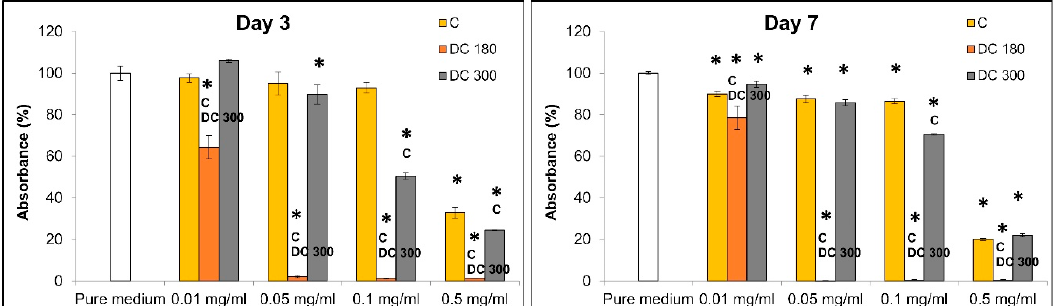
Figure 5. Mitochondrial activity of human dermal fibroblasts grown in a pure cultivation medium and in media with unmodified curcumin (C), or with curcumin degraded at 180 ◦ C (DC 180) or at 300 ◦ C (DC 300) in various concentrations (0.01, 0.05, 0.1, and 0.5 mg / mL) on days 3 and 7 after adding the agent. Arithmetic mean ± SD from 4 measurements, ANOVA, Student–Newman–Keuls method. Statistical significance ( p ≤ 0.05; depicted above the columns): * compared with cells cultivated in the pure medium; C or DC 300 compared with cells cultivated in the medium with C or DC 300 of the same concentration.